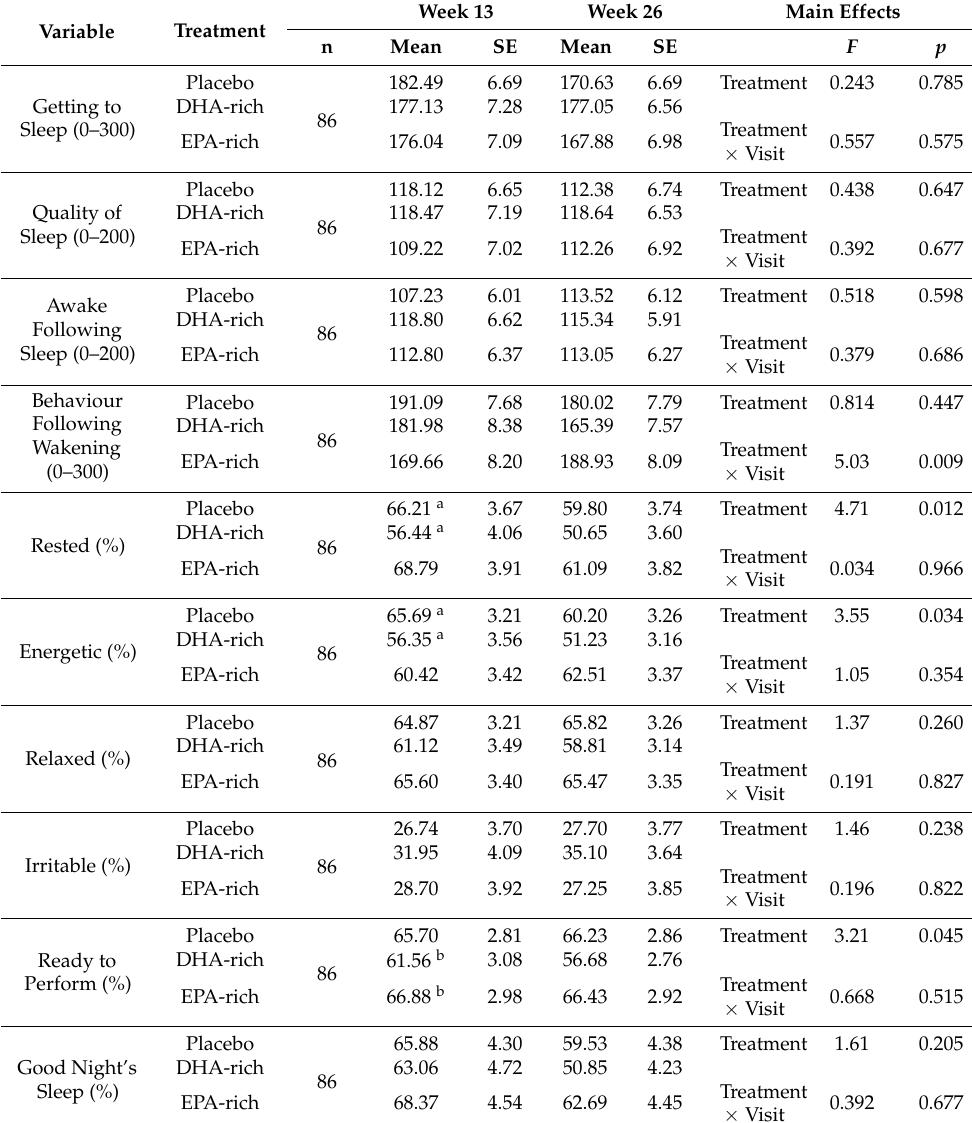
Table 5. Subjective sleep outcomes for the placebo, DHA-rich, and EPA-rich treatment groups. Estimated marginal means and standard error (SE) for week 13 and week 26 are presented with F and p values of the main effects from the linear mixed